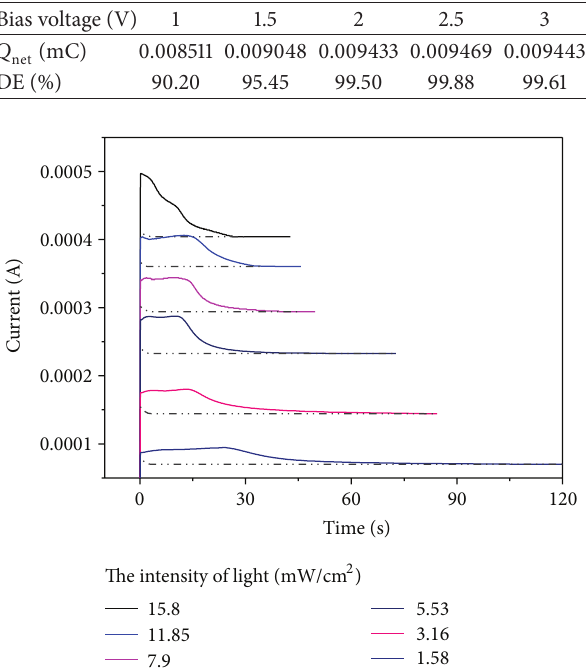
Table 1: 𝑄 value and degradation efficiency (DE) under different net bias voltages.